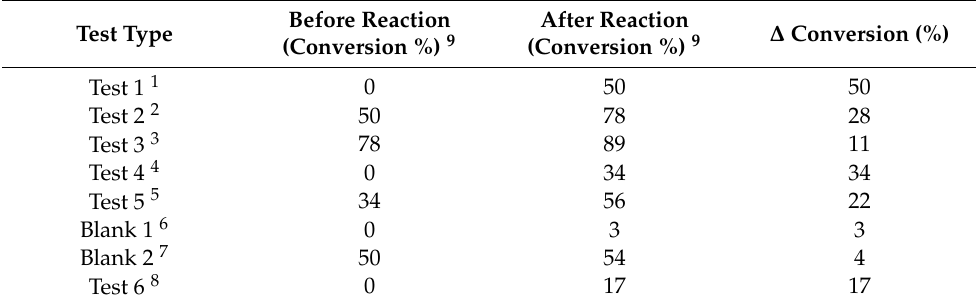
Table 3. Additional experiments for establishing leaching